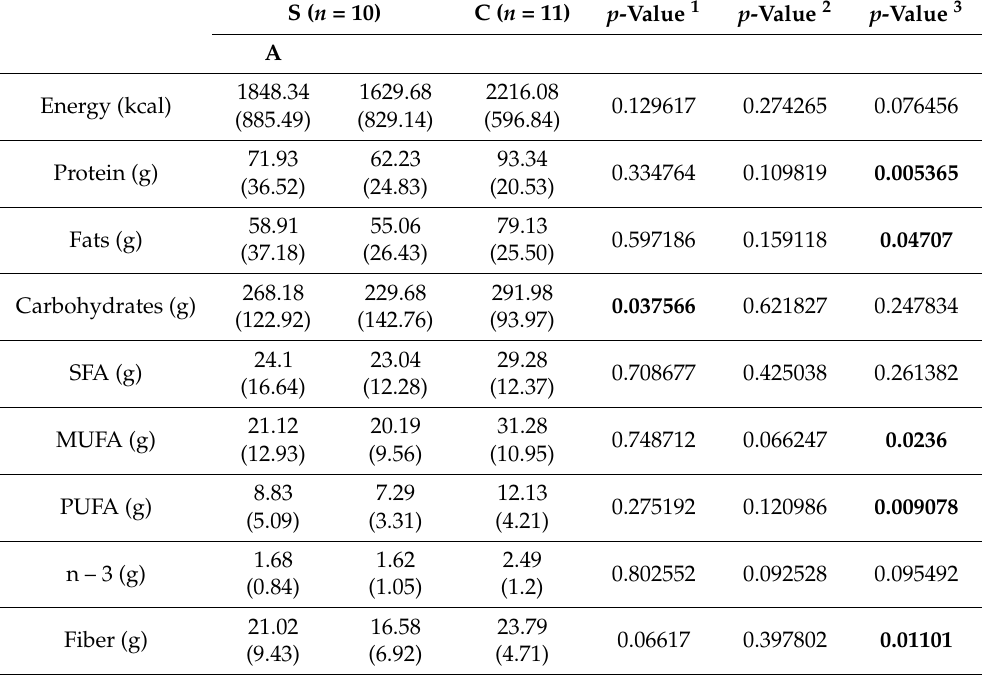
Table 3. Comparison of the average daily consumption of various nutrients in the study and control